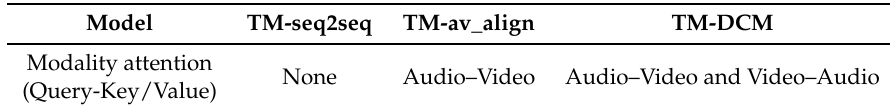
Table 2. Architectural differences in cross-modality attentions between the TM-seq2seq, TM-av_align, and